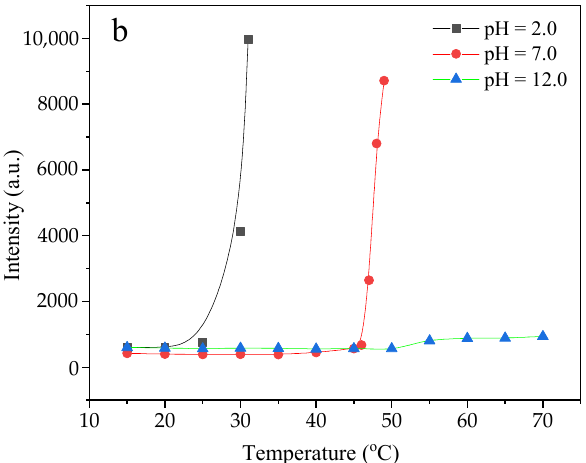
Figure 5. The effect of pH on the fluorescence intensity of poly 14 -N-CQDs at 25 °C ( a ); the plot of scattering peak intensity as a function of the temperature ( b ).